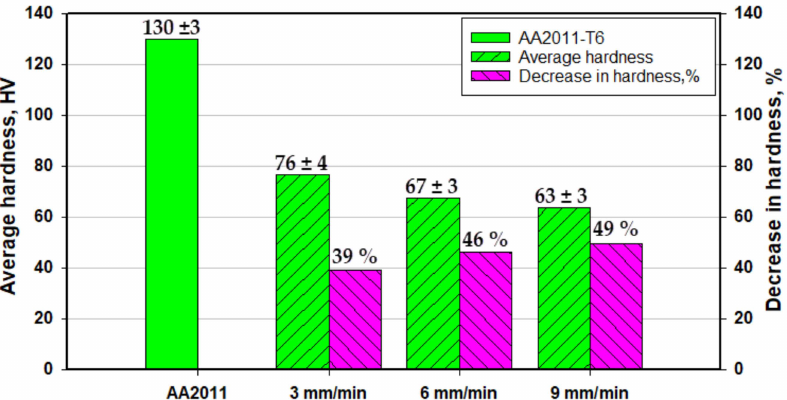
Figure 12. Average hardness and a hardness loss percentage of the AA2011-T6 and its AMPs produced at a rotational rate of 1200 rpm and feed speeds of 3, 6, and 9 mm/min.